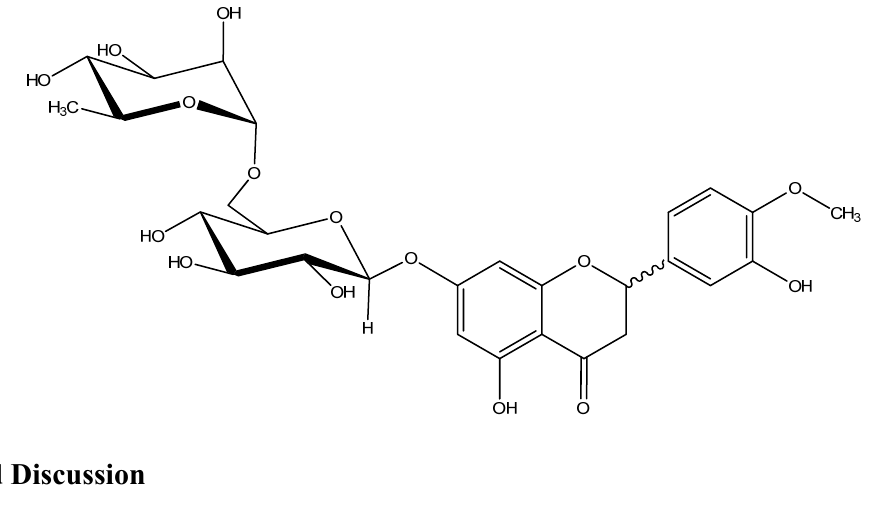
Figure 1. The chemical structure of hesperidin {(±)-2-5-hydroxy-2-(3-hydroxy-4- methoxyphenyl)-7-[(2 S ,3 R ,4 S ,5 S ,6 R )-3,4,5-trihydroxy-6-[[(2 R ,3 R ,4 R ,5 R ,6 S )-3,4,5-trihydroxy-